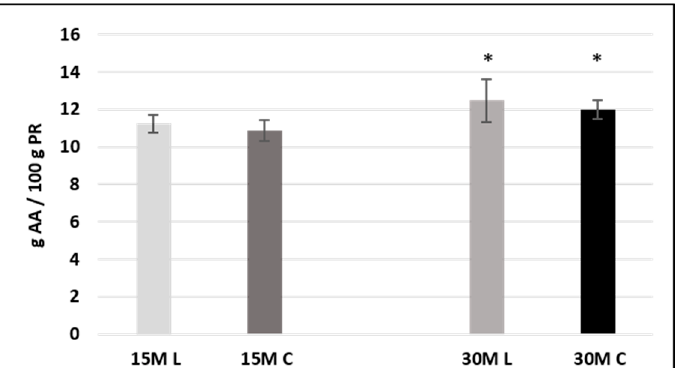
Figure 2. Free amino acid content (g AA/100 g PR) in sample groups. Samples are labeled according to their ripening time (15-month-ripened samples: light-gray and dark-gray bars; 30-month-ripened samples: gray and black bars) and their salt content (low-salt samples are labeled L, whereas conventional samples are labeled C). Differences are considered significant at p < 0.05 (*).